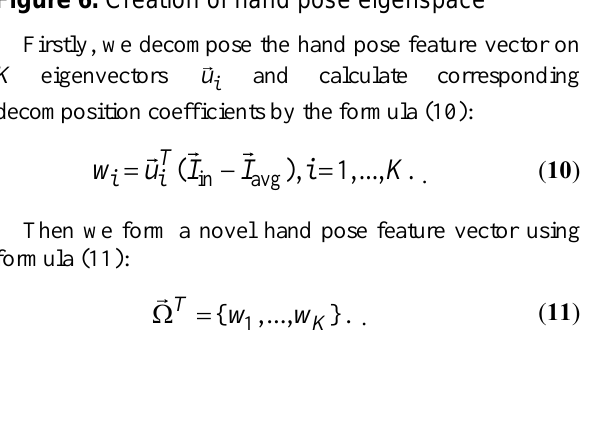
Figure 6. Creation of hand pose eigenspace